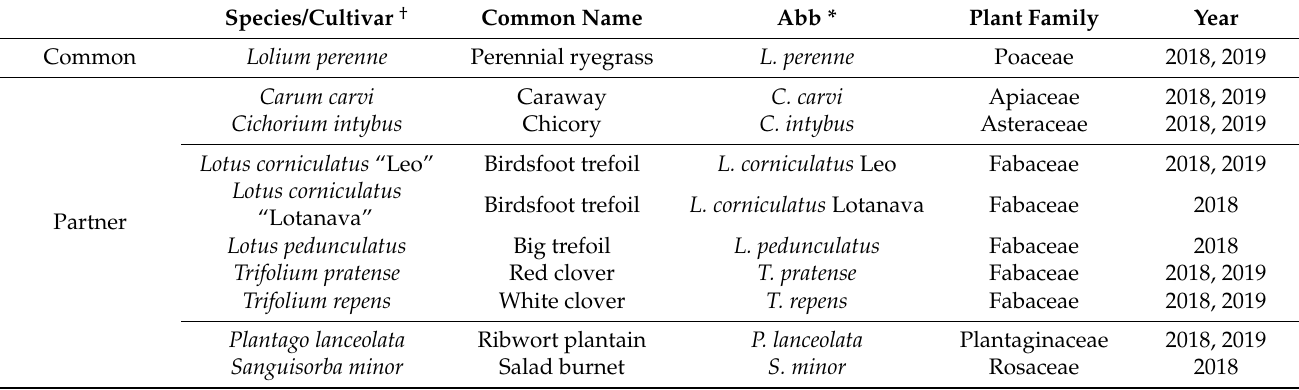
Table 1. Plant species combined for the in vitro Hohenheim gas test (HGT), cultivar, common name, abbreviation, plant family and year of